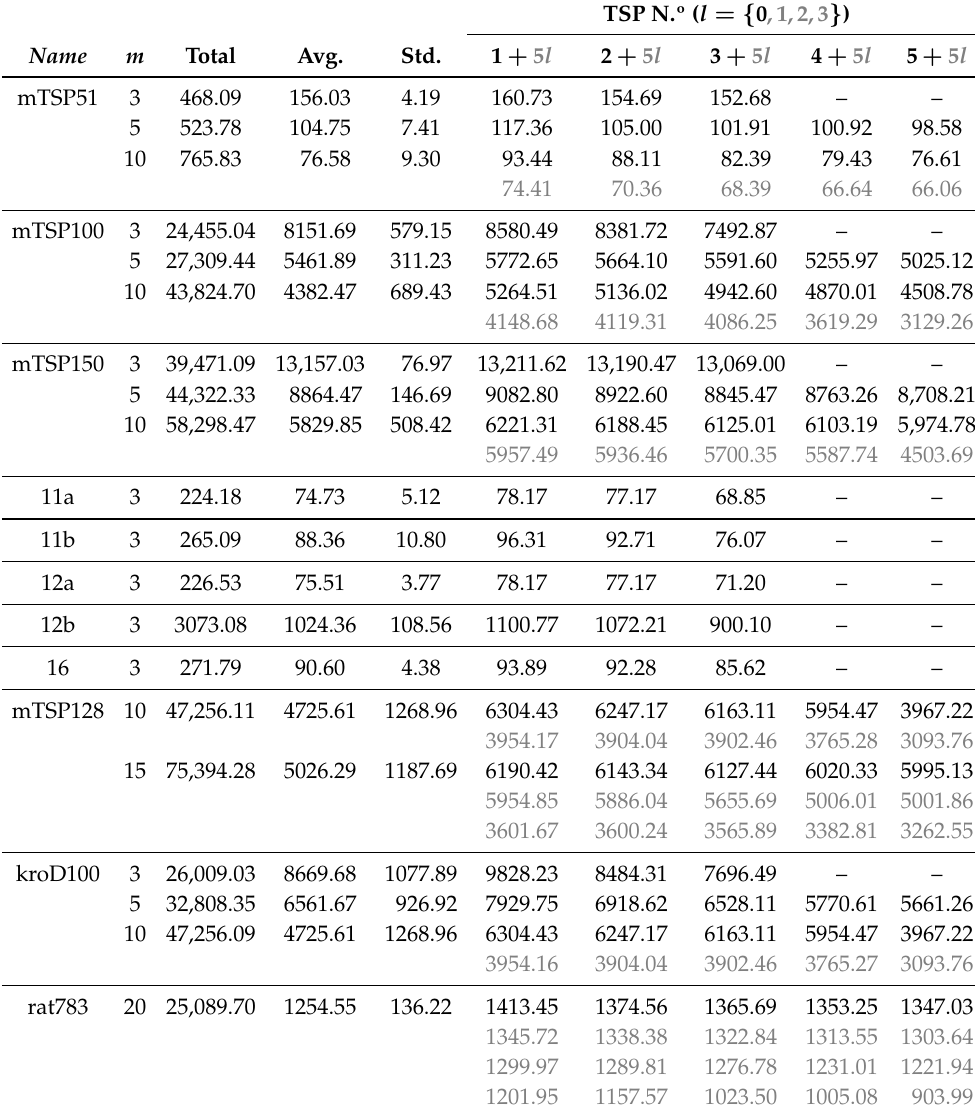
Table 2. Total and partial distance traveled by salesmen when using the ACO-BmTSP